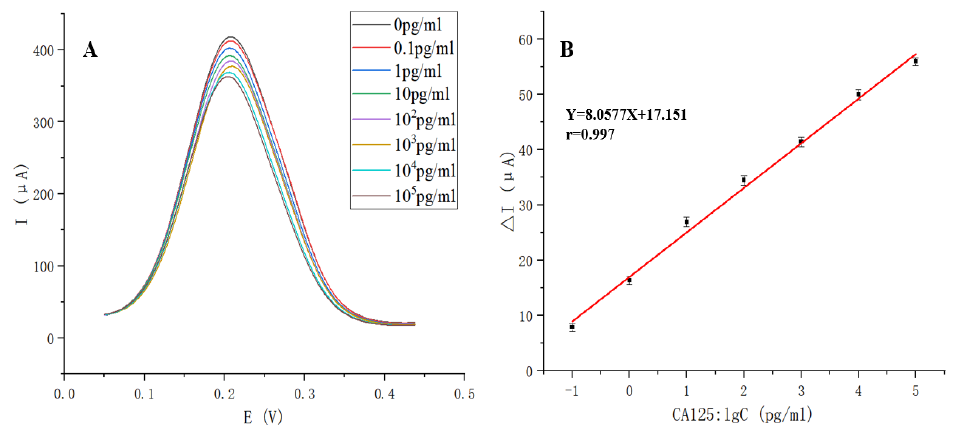
Figure 6. ( A ) DPV signals of CA125 with different concentrations; ( B ) the calibrated curve of the immunosensor toward different concentrations of CA125.